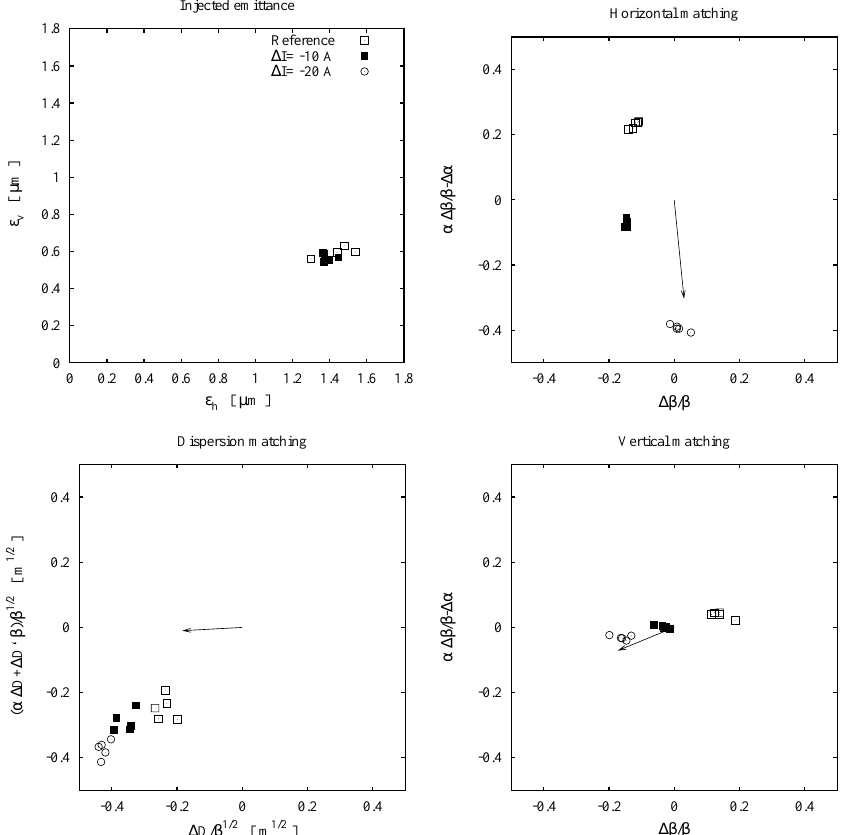
FIG. 9. Injected emittance, betatron, and dispersion mismatch vectors for three different settings of a transfer line quadrupole. Note the large dispersion mismatch. The vectors illustrate the variation in mismatch that is expected for a correction of 2 10 A (calculated from beam optics theory). There is a good agreement between expected and measured behavior, indicating that the measurement works well.